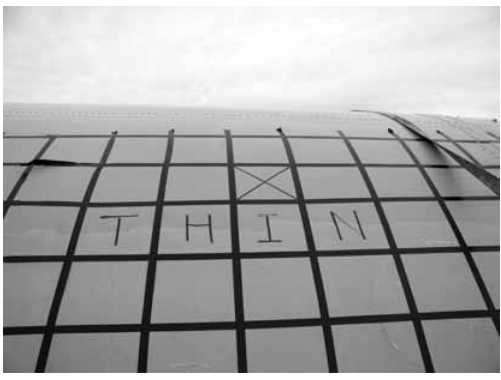
Fig. 26. Outside view of aircraft section before thin shield